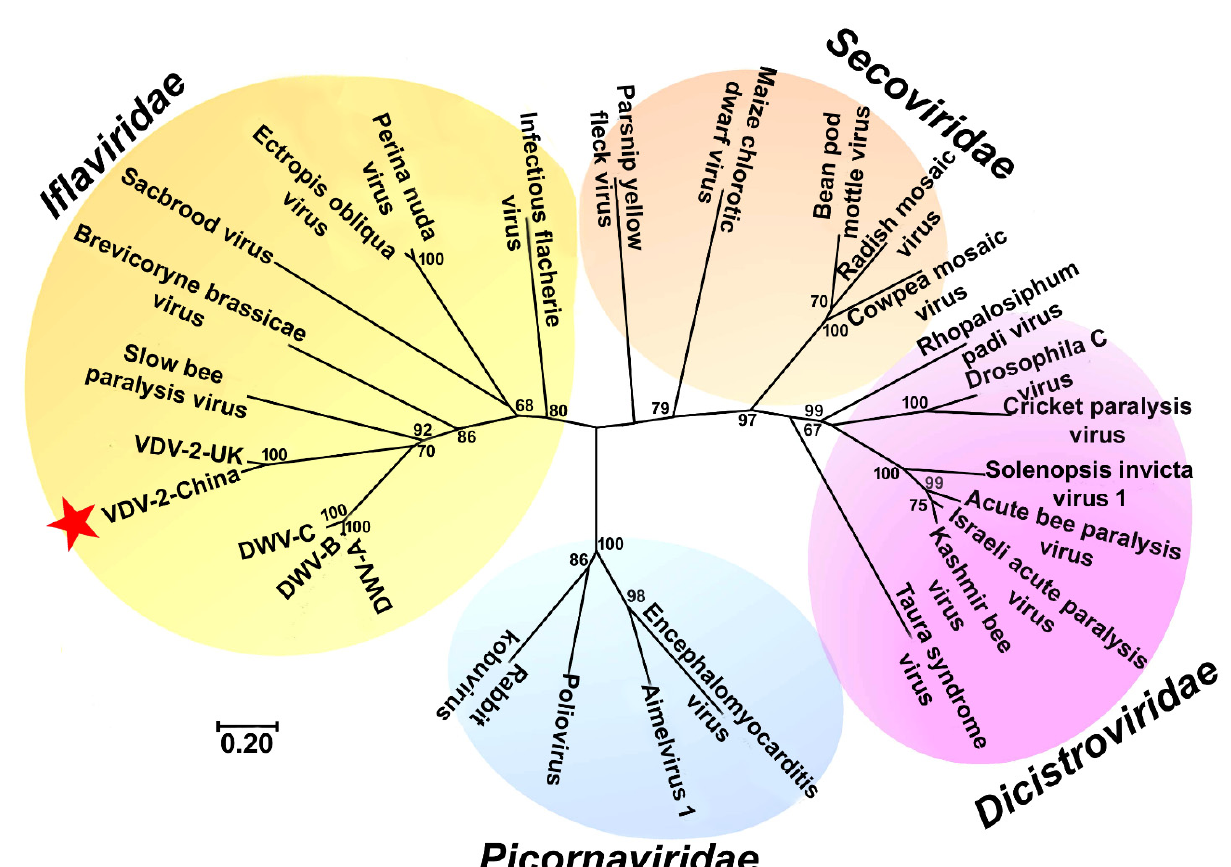
Figure 2. Unrooted phenogram showing the relationship of VDV-2-China with other viruses in the families Iflaviridae , Dicistroviridae , Secoviridae , and Picornaviridae . The phylogenetic analysis was conducted in MEGA 7 based on the amino acid sequences of the putative structural polyprotein using the neighbor-joining method. The tree is drawn to scale, with the same unit used for the branch lengths as those of the evolutionary distances that are used to infer the phylogenetic tree. The scale bar shows the number of substitutions per base. The neighbor-joining phenogram was bootstrapped 1000 times with values greater than 60% given at the nodes.